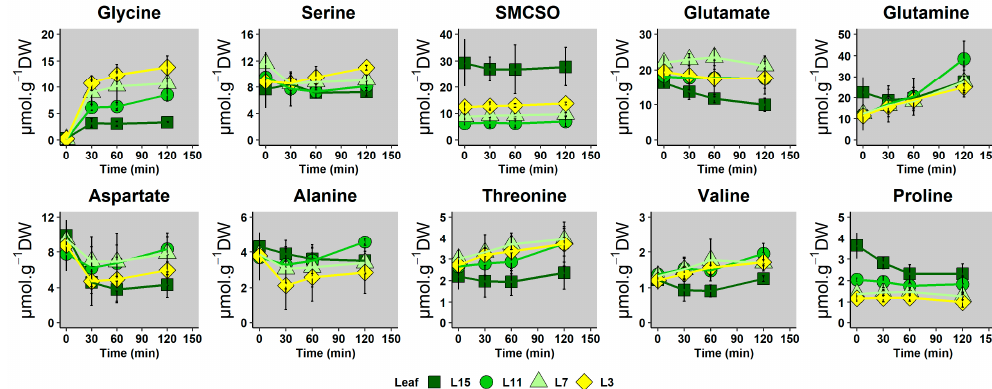
Figure 3. Time-course concentrations of the most abundant amino acids in leaf ranks with a different sink/source balance during an instationary labeling experiment with [ 15 N] L -glycine as the sole nitrogen source. Leaf discs from the four leaf ranks having a different sink/source balance were floated during 0, 30, 60 or 120 min in a buffer containing 10 mM [ 15 N] L -glycine, under continuous light and orbital shaking. Amino acid quantification was achieved with a UPLC-DAD system. Values are the mean ± SD of 3 independent biological replicates for each leaf group and each time-point. Complete dataset is available in Supplementary Table S2.